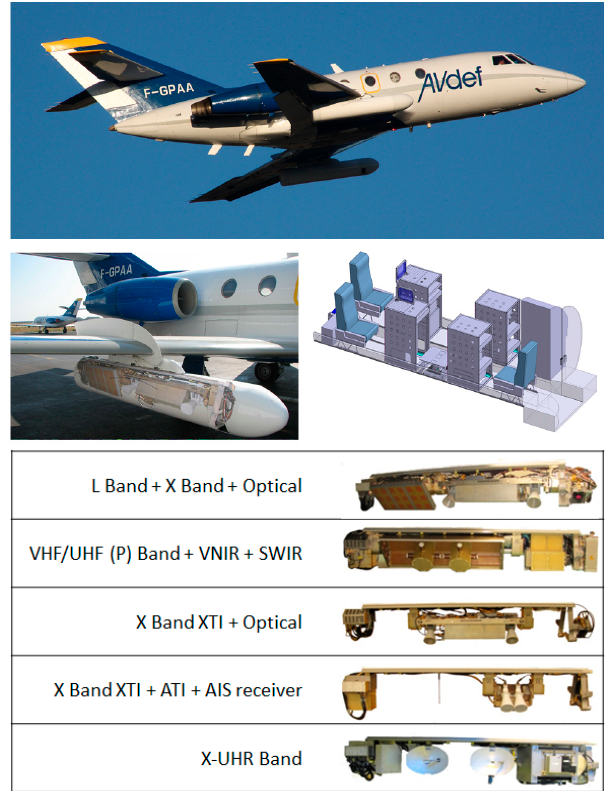
Figure 2. SETHI platform (aircraft, pod and cabin layout) and in-pod payload configuration examples.